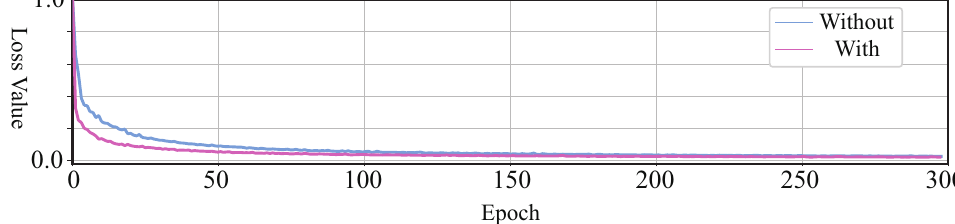
Figure 19. Loss curve in training with and without the self-attention block.